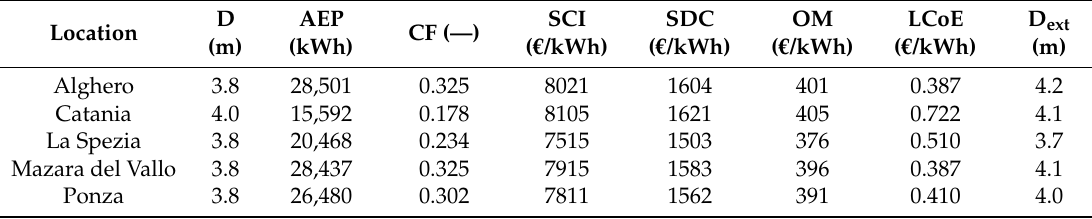
Figure 5. LCoE distribution versus the diameter of the buoy with the fully submerged mass. Table 7. Main data of WEC devices with the fully submerged